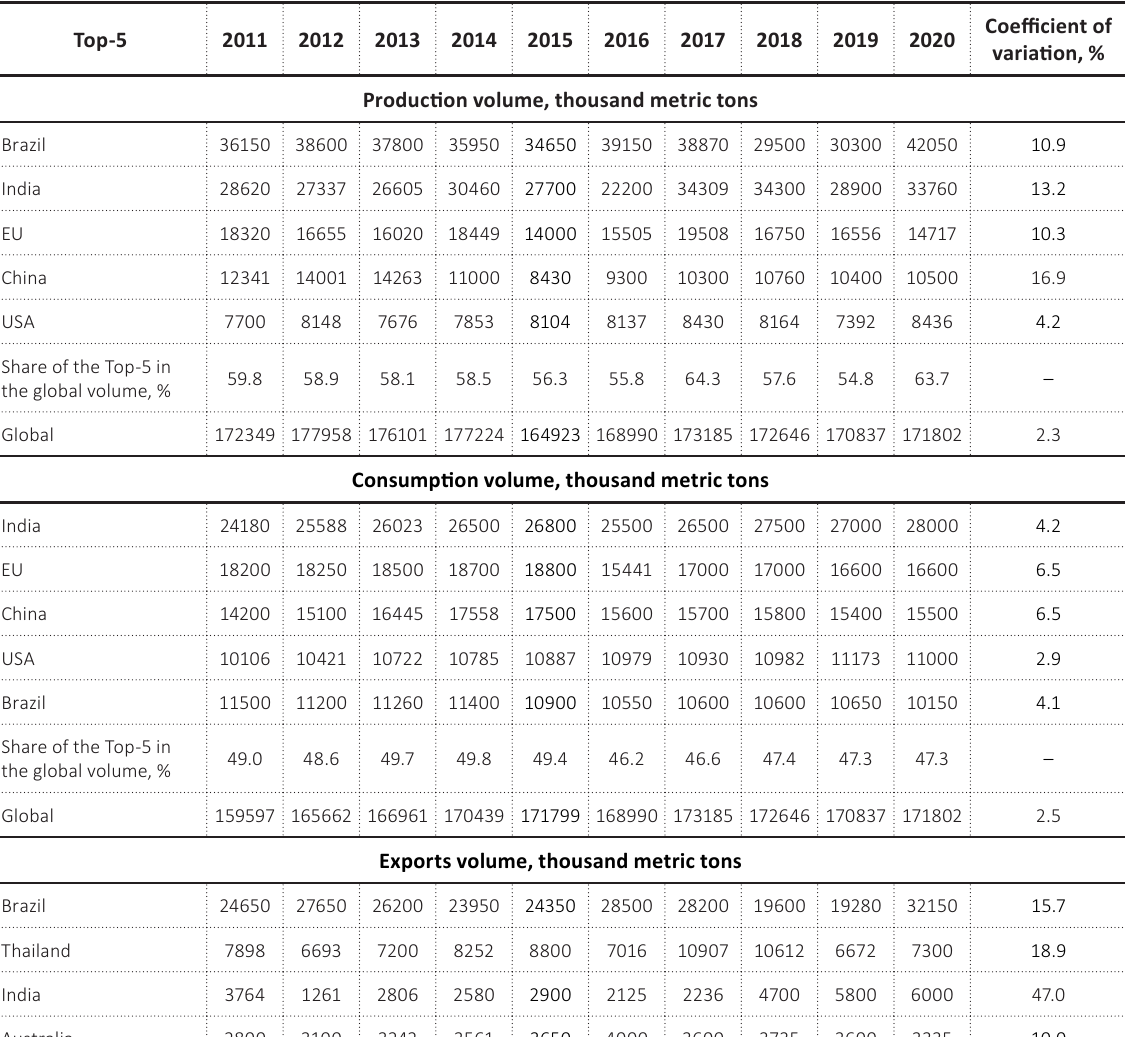
Table A3. Coefficient of variation for the dynamic set of indicators of the global sugar market